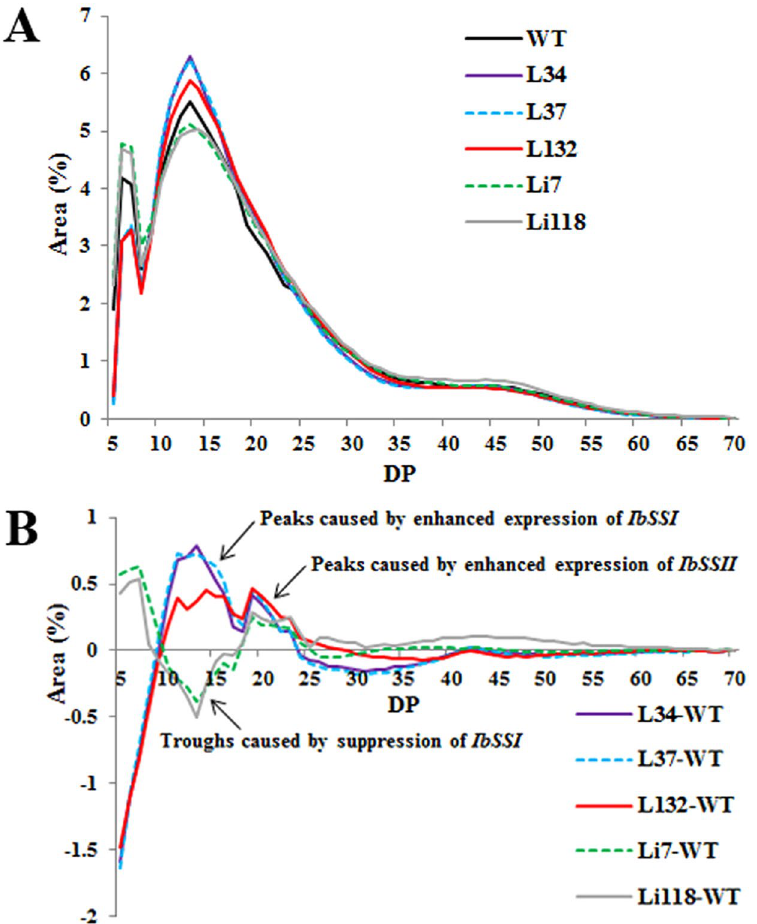
Figure 7. Amylopectin chain length distributions of the transgenic plants and WT. ( A ) CLD of the starch isolated from the five transgenic lines and WT after normalization to the total peak area. ( B ) Differences in the CLD between the transgenic lines and WT were calculated as follow: the normalized CLD value for each transgenic line minus the value obtained for the